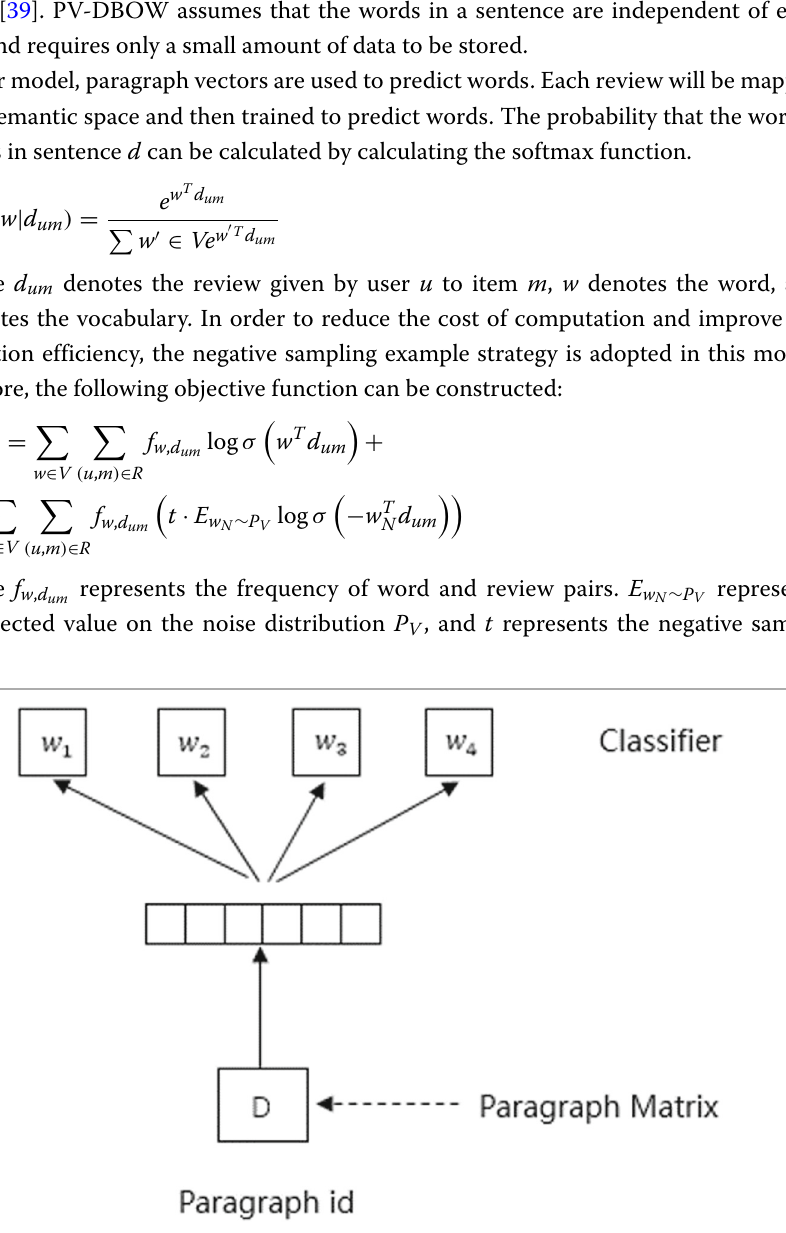
Fig. 4 Distributed Bag of Words of Paragraph